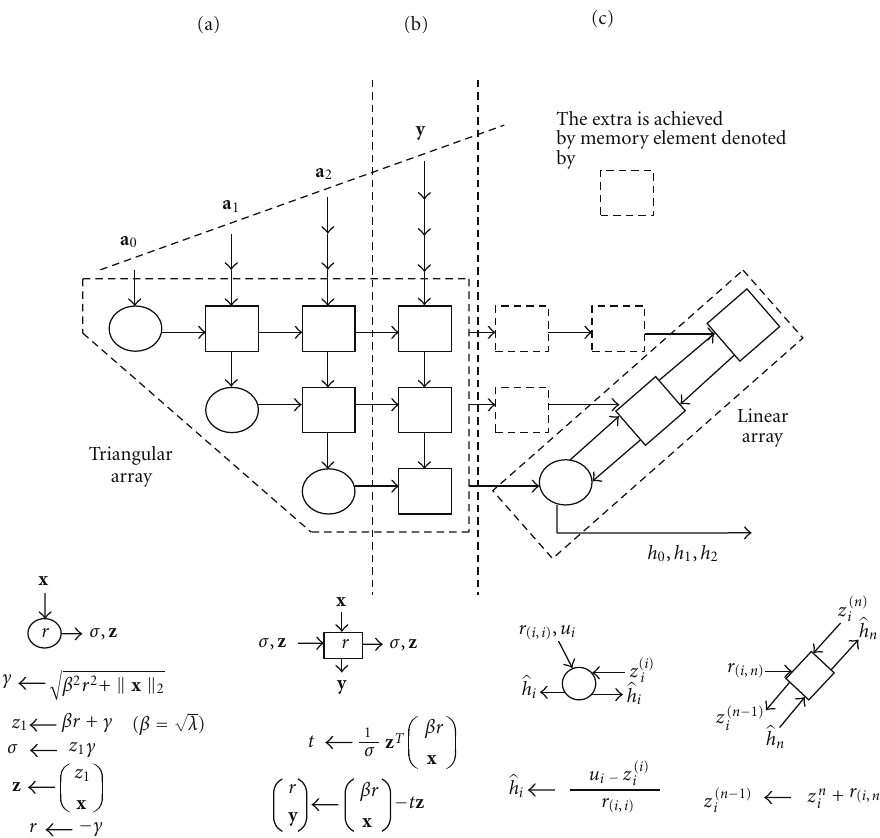
Figure 2: Systolic array implementation of channel estimation section of CPE2 (using Householder transformations) with processing cell